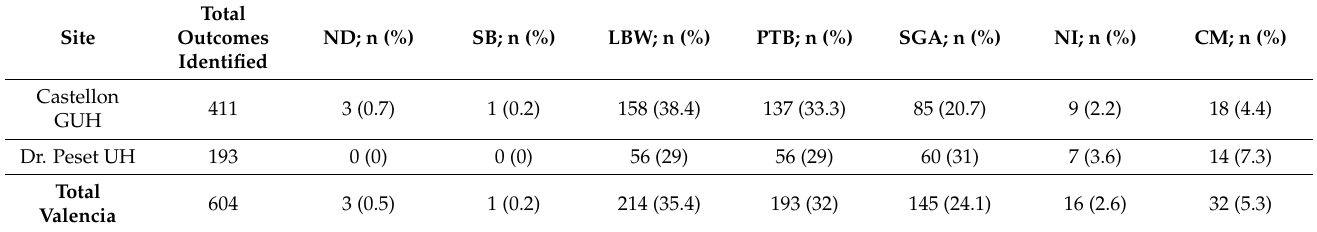
Table 2. Number of total perinatal and neonatal study outcomes identified at the screening stage during the study period. Number of total cases identified in the study for each of the outcomes, per site and in total in Valencia Region. Abbreviations: ND: neonatal death; SB: stillbirth; LBW: low birth